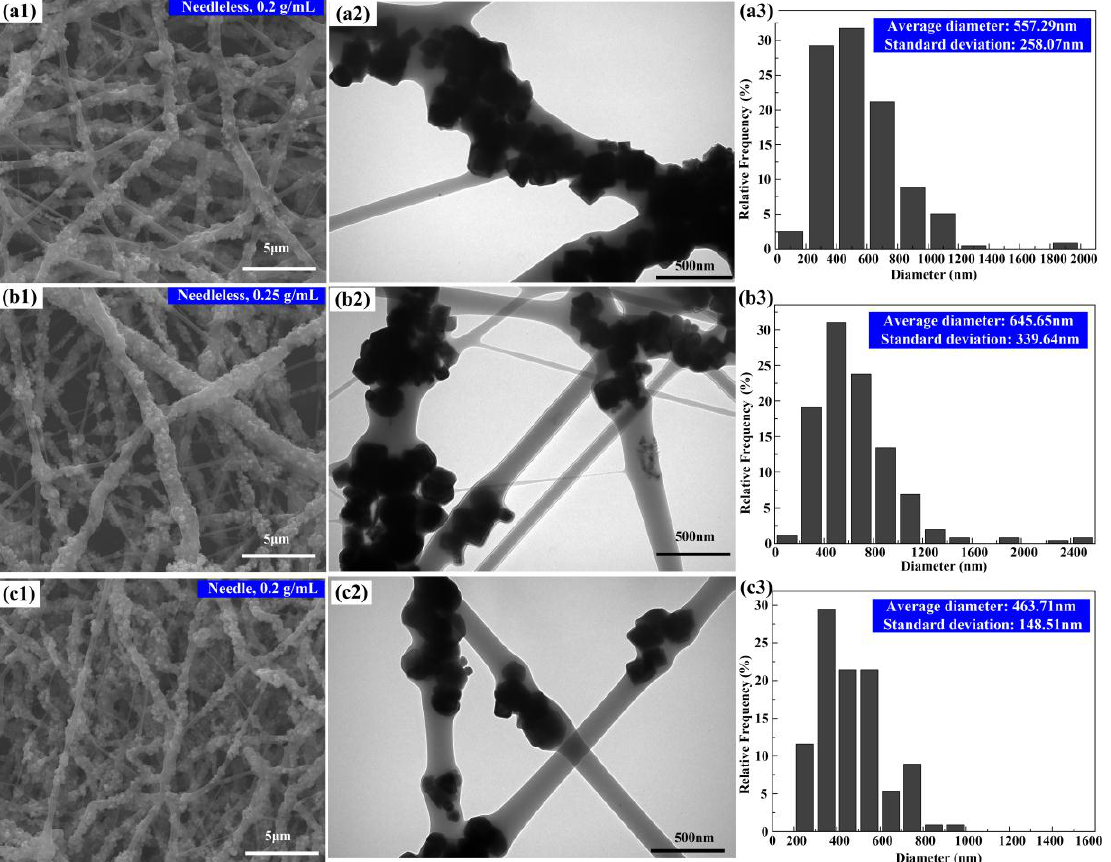
Figure 3. SEM images, TEM images, and the respective diameter histogram, of PVP/Fe 3 O 4 nanofibers. Nanofibers fabricated by multiple needleless electrospinning with Fe 3 O 4 concentration of ( a ) 0.2 g/mL and ( b ) 0.25 g/mL. ( c ) Nanofibers fabricated by conventional electrospinning with a Fe 3 O 4 concentration of 0.2 g/mL.